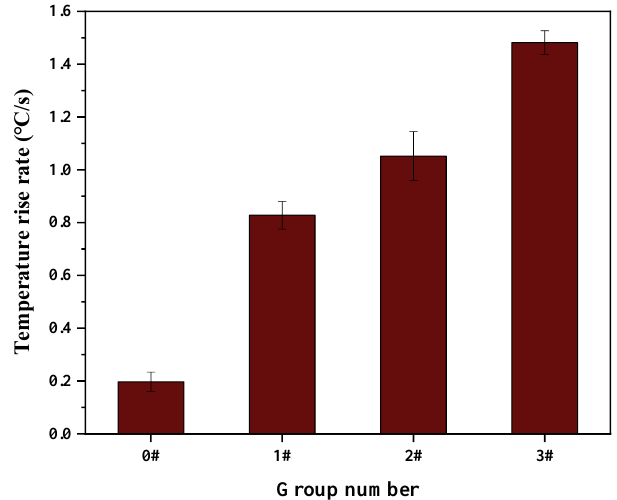
Figure 7. Temperature rise rate of UMLs with different SiC particle sizes.